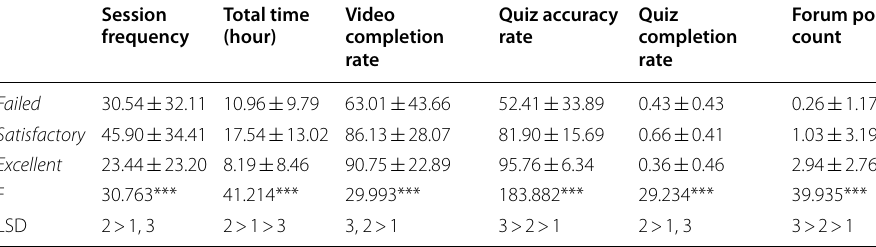
Table 5 Group differences in the learning engagement